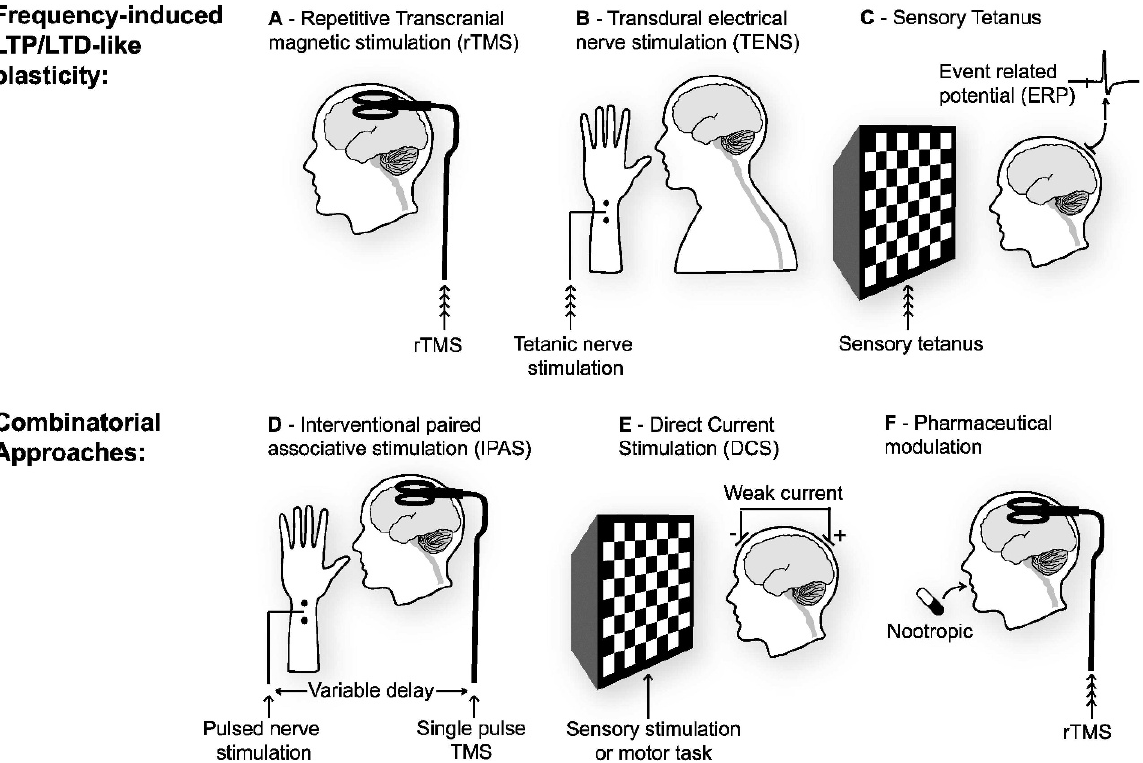
Figure 3 - Non-invasive methods of inducing synaptic plasticity in the human CNS. ( A ) Repetitive trains of transcranial magnetic stimulation (rTMS), have been employed in several regions of the brain to induce LTP- and LTD-like changes in spontaneous neural activity and responsiveness to stimulation. This approach is limited in the frequencies that can be attained and is restricted to surface structures in the brain, primarily cortical, close enough to the TMS device for effective stimulation. ( B ) Direct transdural electrical nerve stimulation (TENS) can be used to deliver trains of stimuli to afferent fibres and induce LTP- or LTD-like changes within the spinal cord. ( C ) Work in primary sensory cortices, notably visual and auditory cortex, has revealed that repetitive sensory stimulation, either flashes or tones, can induce lasting LTP- or LTD-like changes in event-related potentials (ERPs) recorded in these regions. ( D ) Approaches which combine two of the techniques described above ( A-C ) can be used to induce changes in synaptic strength that often have the